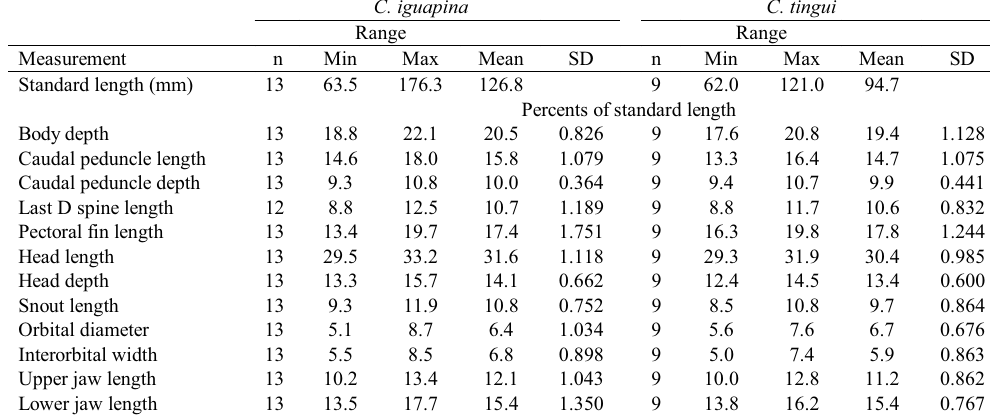
Table 2. Morphometry of Crenicichla iguapina and C. tingui . n= number of specimens; SD= Standard